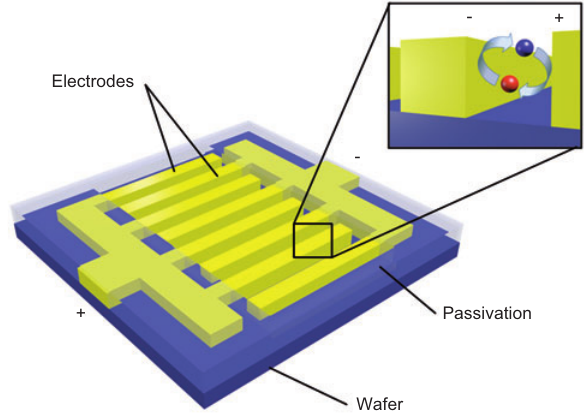
Figure 3 Illustration of an interdigitated array sensor. Both elec- trodes can be biased individually via feed lines that are covered under a thin passivation layer. Inset: Redox cycling occurs in between the electrodes. Oxidized molecules are indicated by a red sphere, reduced molecules by a blue